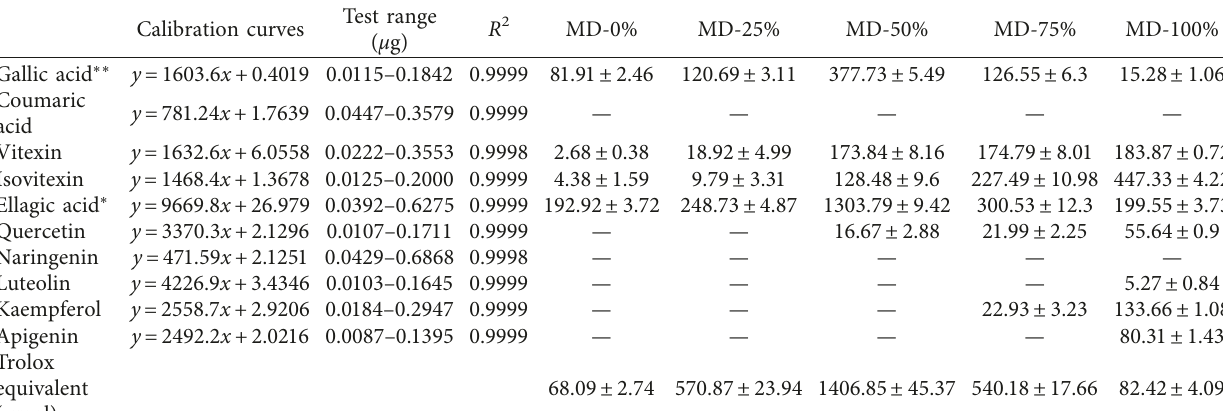
Table 6: The contents of antioxidants and ten main flavonoids and phenolic acids in five fractions from MD. Calibration